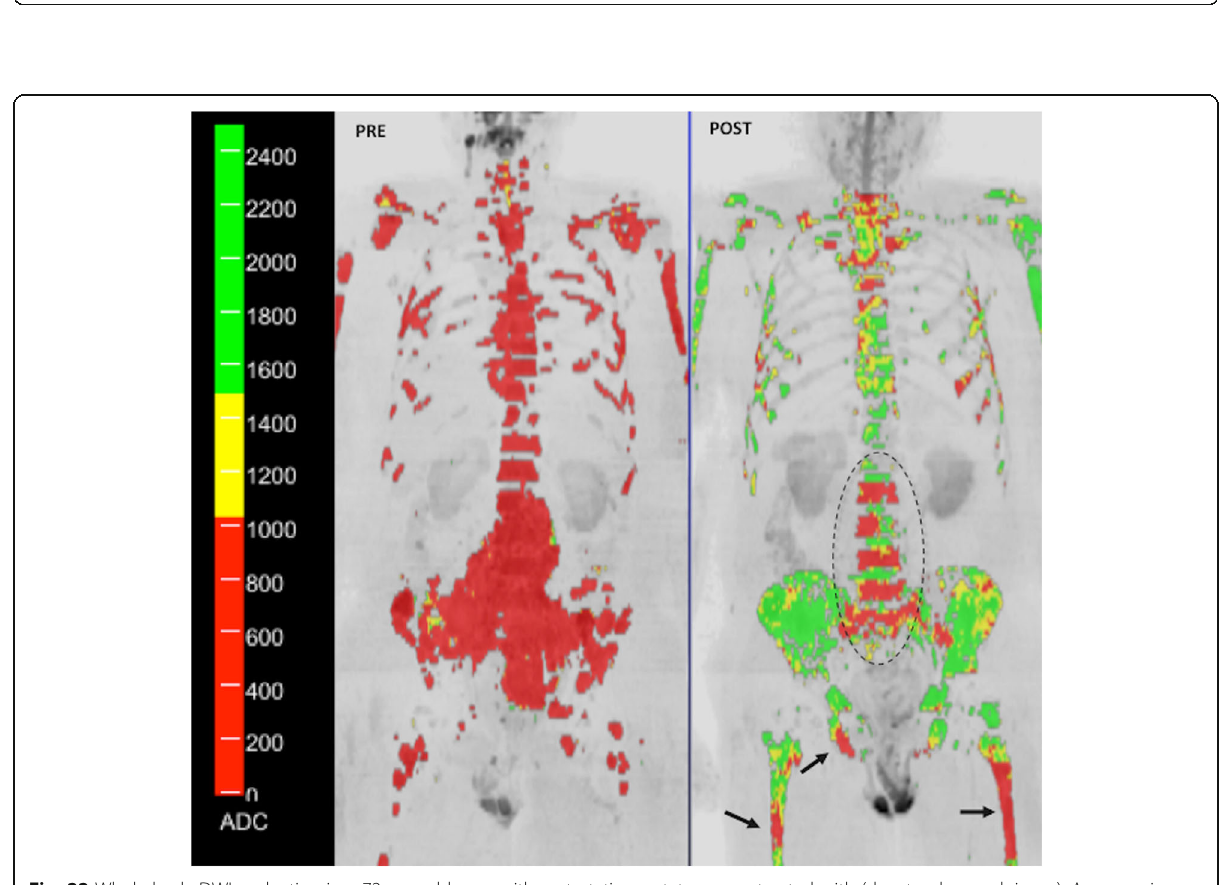
Fig. 22 Whole-body DWI evaluation in a 72-year-old man with metastatic prostate cancer treated with (docetaxel + prednisone). A comparison between images pre (left) and posttherapy (right) demonstrated that tumor volume decreased (1280 cm 3 → 640 cm 3 ) and mean ADC moved from 0.7 to 1.61 confirmed an increasing % of voxels at higher ADC values after therapy consistent with reductions in cellularity due to tumor necrosis. However, tumor response was heterogeneous in this patient and there were some anatomical areas that presented a limited tumor response (black dotted circle on lumbar spine and black arrows)